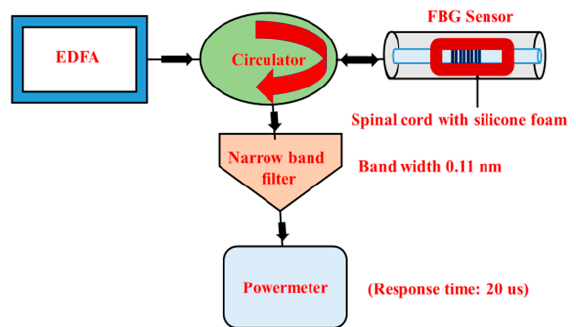
Figure 7. Experimental setup of the strain FBG sensor based on a fixed narrow-band optical filter and a fast photodiode (i.e., power